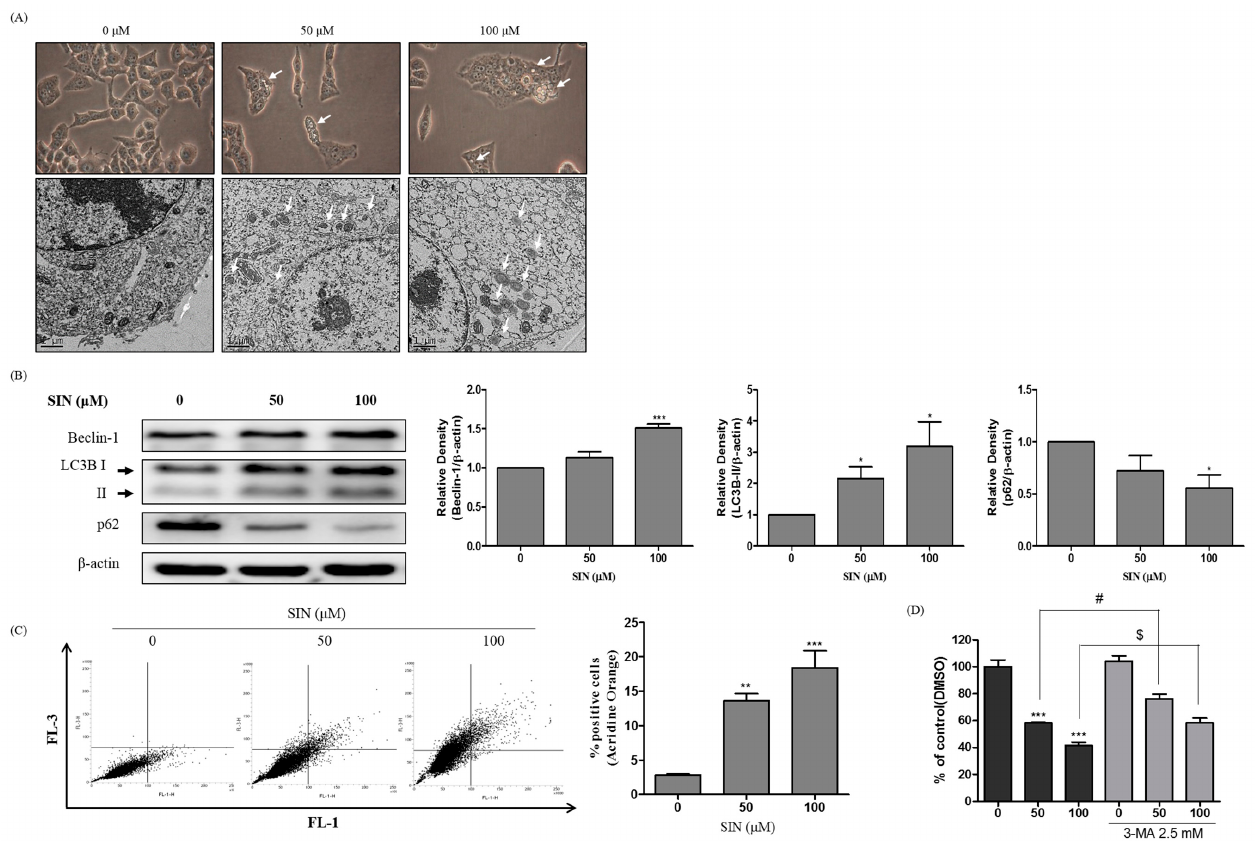
Figure 3. Autophagy is triggered in SIN-treated HepG2 cells. ( A ) The images above shows HepG2 cells treated with SIN for 48 h. The cell morphology was examined Figure 3 by phase-contrast microscopy. The images below shows the autophagic vesicles were visualized by TEM and are indicated by white arrows. ( B ) HepG2 cells were treated with SIN for 48 h. Autophagy markers were investigated by immunoblotting. β -actin was used as a loading control. The quantified expressions by Image J software were plotted in the bar graphs. ( C ) The cells were exposed to SIN for 48 h. Then, the cells were stained with AO to detect AVOs by flow cytometry and the percentage of positively stained cells was calculated. ( D ) The cells were exposed to SIN with or without 2.5 mM 3-MA. Cell viability was analyzed by the MTT assay. The mean ± SEM of three independent experiments is expressed as a percentage compared to vehicle control. * p < 0.05 vs. vehicle control; ** p < 0.01 vs. vehicle control; *** p < 0.001 vs. vehicle control; # p < 0.05 vs. compared to the 50 µ M SIN-treated group; $ p < 0.05 vs. compared to the 100 µ M SIN-treated